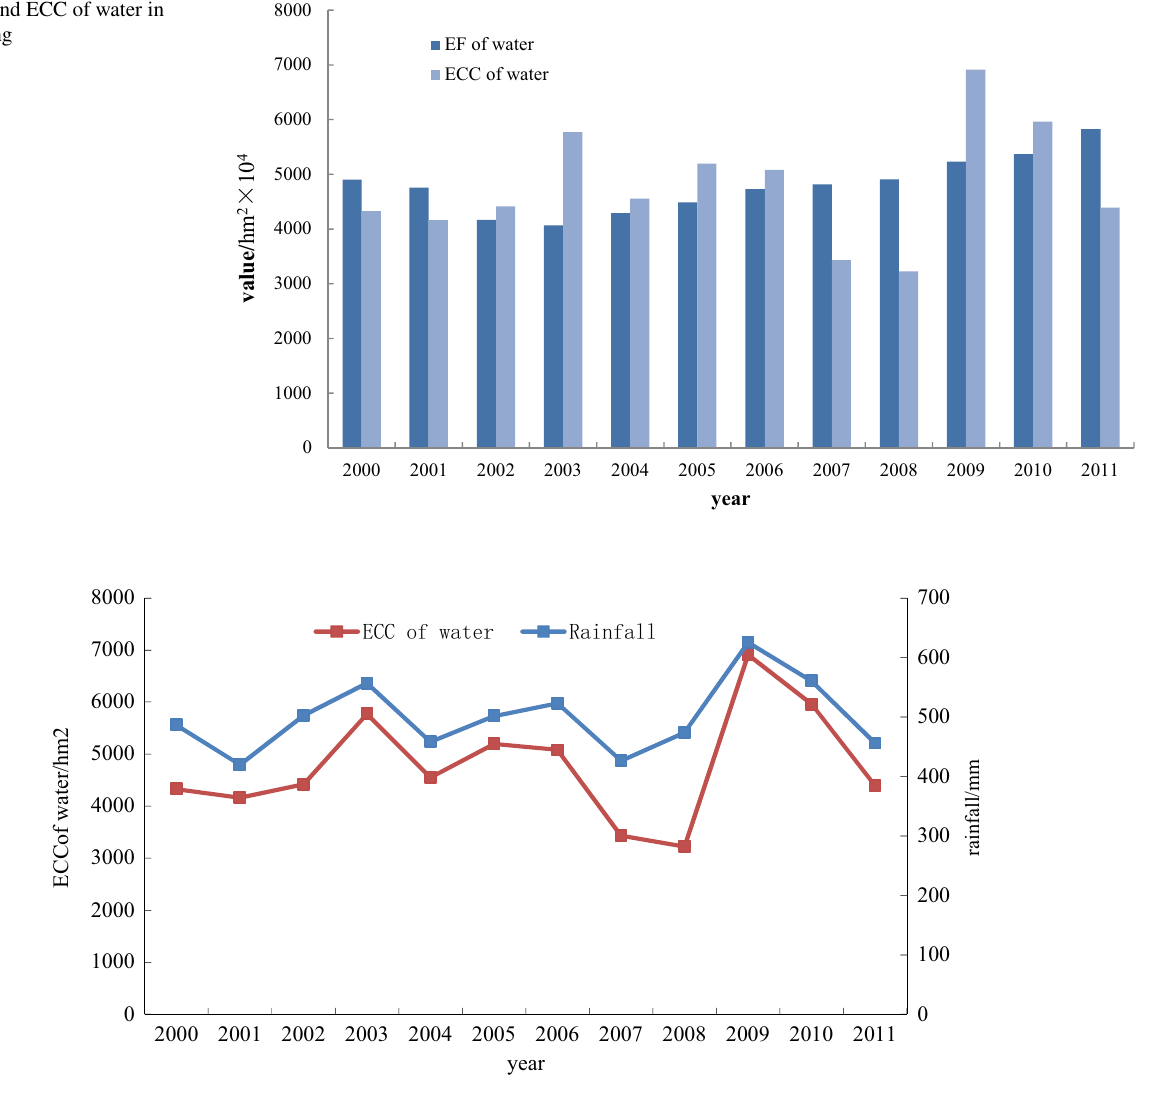
Fig. 6 Relation between the ECC and the